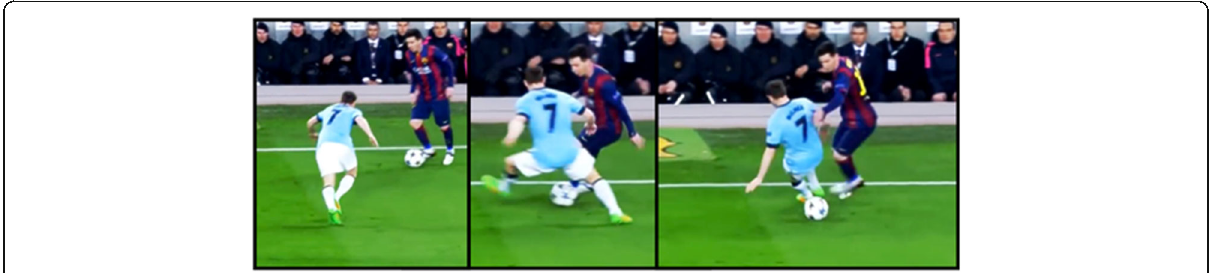
Fig. 2 L. Messi enacting a tunnel to escape from a defender close to the